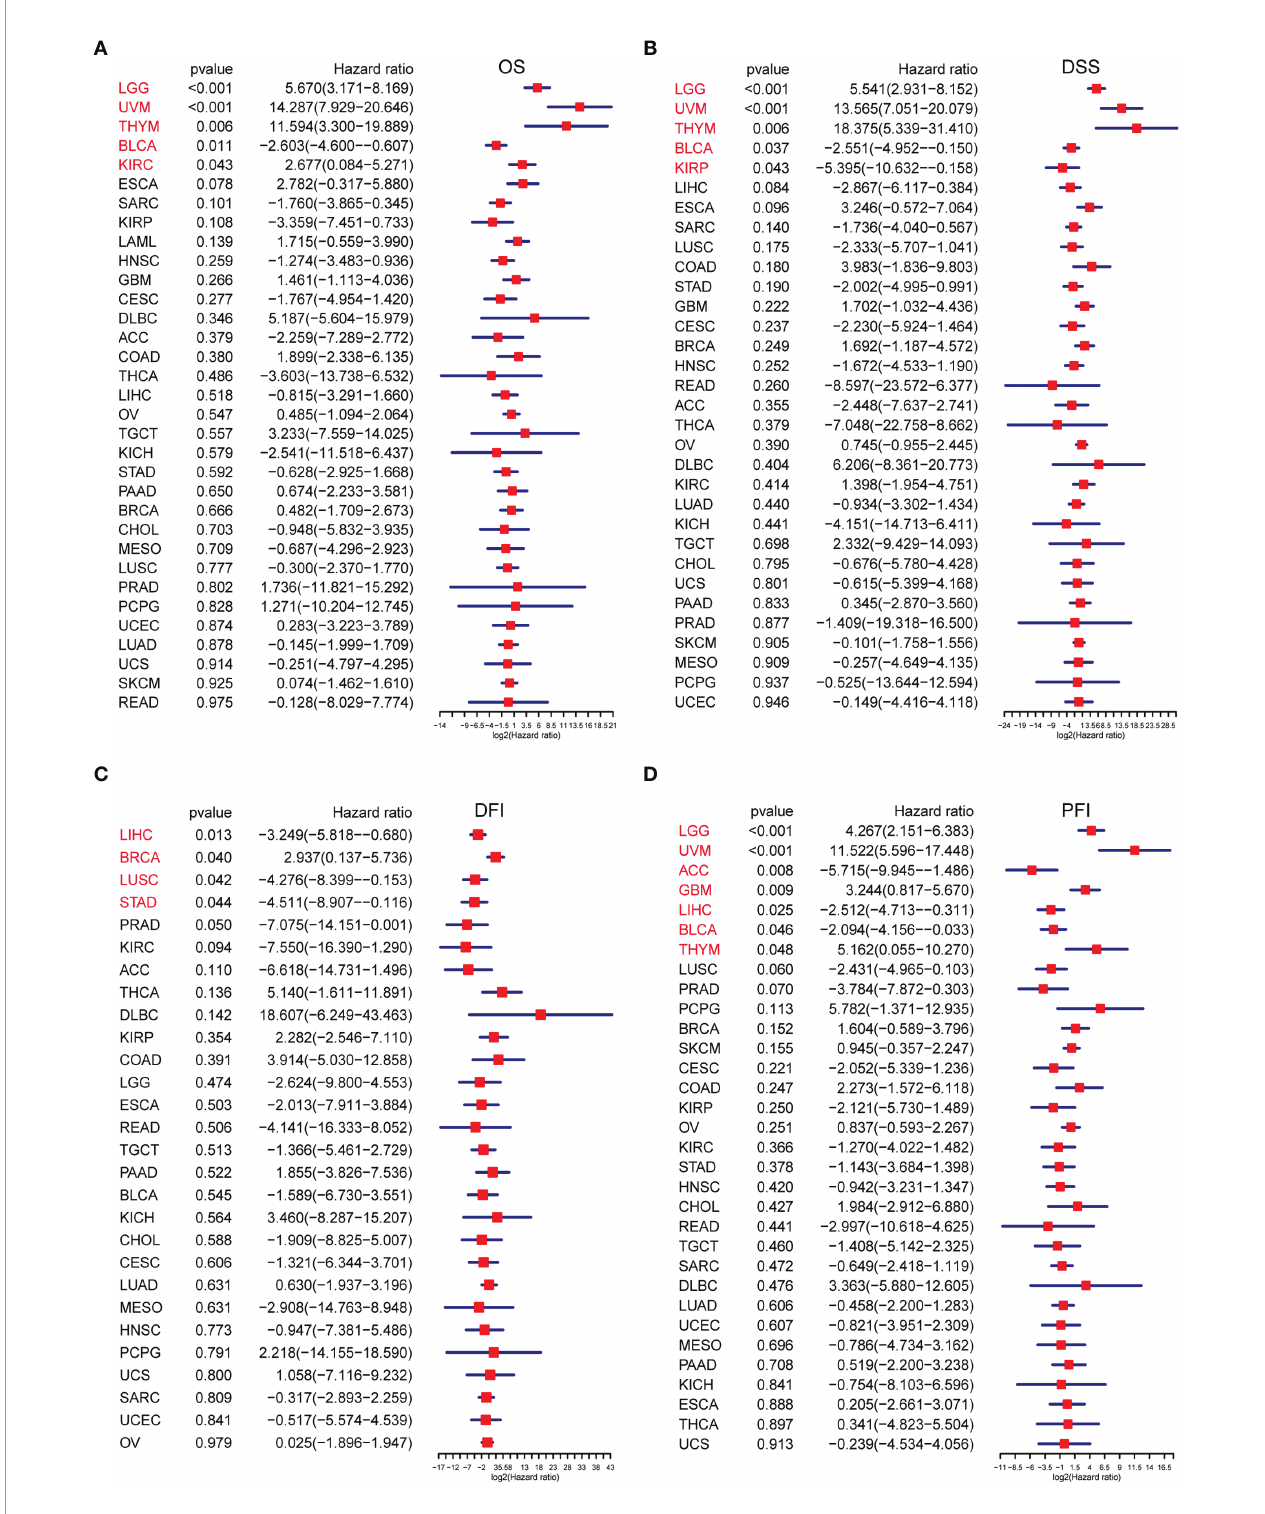
FIGURE 8 | The survival analysis of TRP score. (A – D) Forest plots of the Cox analysis results of TRP score in pan-cancer. (A) Overall survival, (B) disease-speci fi c survival, (C) disease-free interval, and (D) progression-free